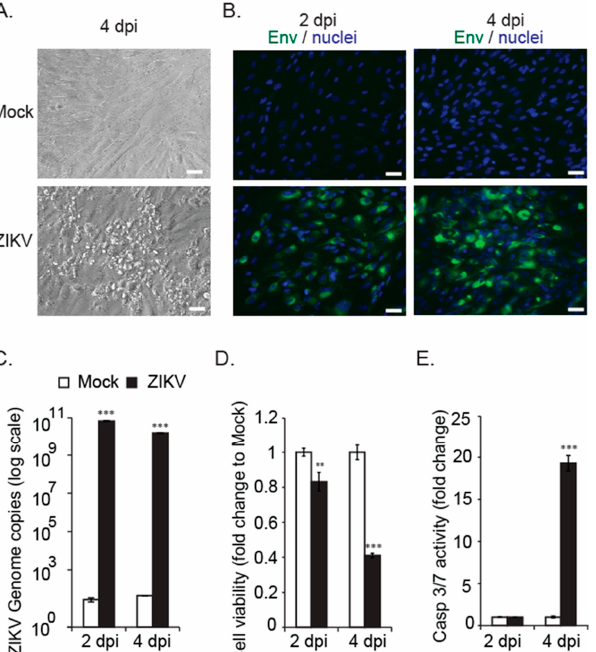
Figure 1. Fetal RPE cells are susceptible to ZIKV infection. ( A ) Bright field images of uninfected (mock) and ZIKV infected FRPE cells at 4 days post-infection (dpi). ( B ) Immunocytochemistry analysis of mock and ZIKV infected FRPE cells at 2 and 4 dpi. Flavivirus envelope protein is shown in green and nuclei in blue. Scale bar: 25 µm. ( C ) Graph shows the ZIKV genome copies (log scale) of mock and ZIKV infected cells at the indicated time points. ( D ) Bar graph shows reduced cell viability of ZIKV infected cells. ( E ) Caspase 3/7 activity measured for mock and ZIKV-infected cells at 2 and 4 dpi. Student t-test was performed for statistical significance, where the p value was p < 0.001 (**); and p < 0.0001 (***). Representative data from three independent experiments are shown.